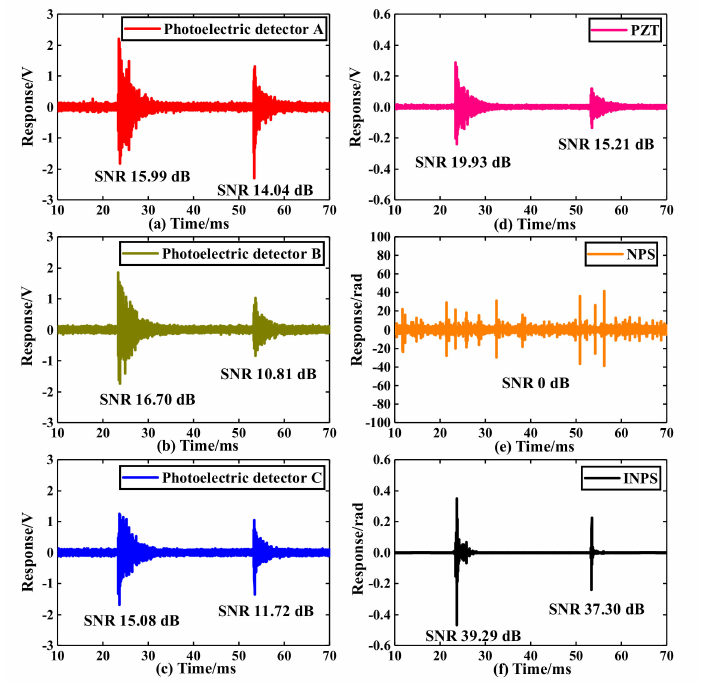
Figure 4. Results of PD detection in the liquid–solid composite dielectric (( a – c ) are the results of three photodetectors with 60–300 kHz digital band-pass filtering, respectively. ( d ) is the result of PZT with the same band-pass filtering. ( e , f ) are the NPS and INPS method results,